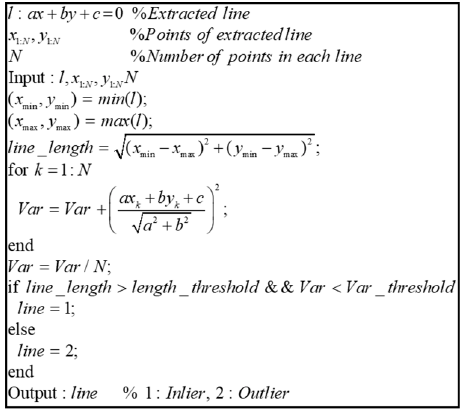
Figure 8. Result of line fitting using iterative-end-point-fit (IEPF) algorithm.